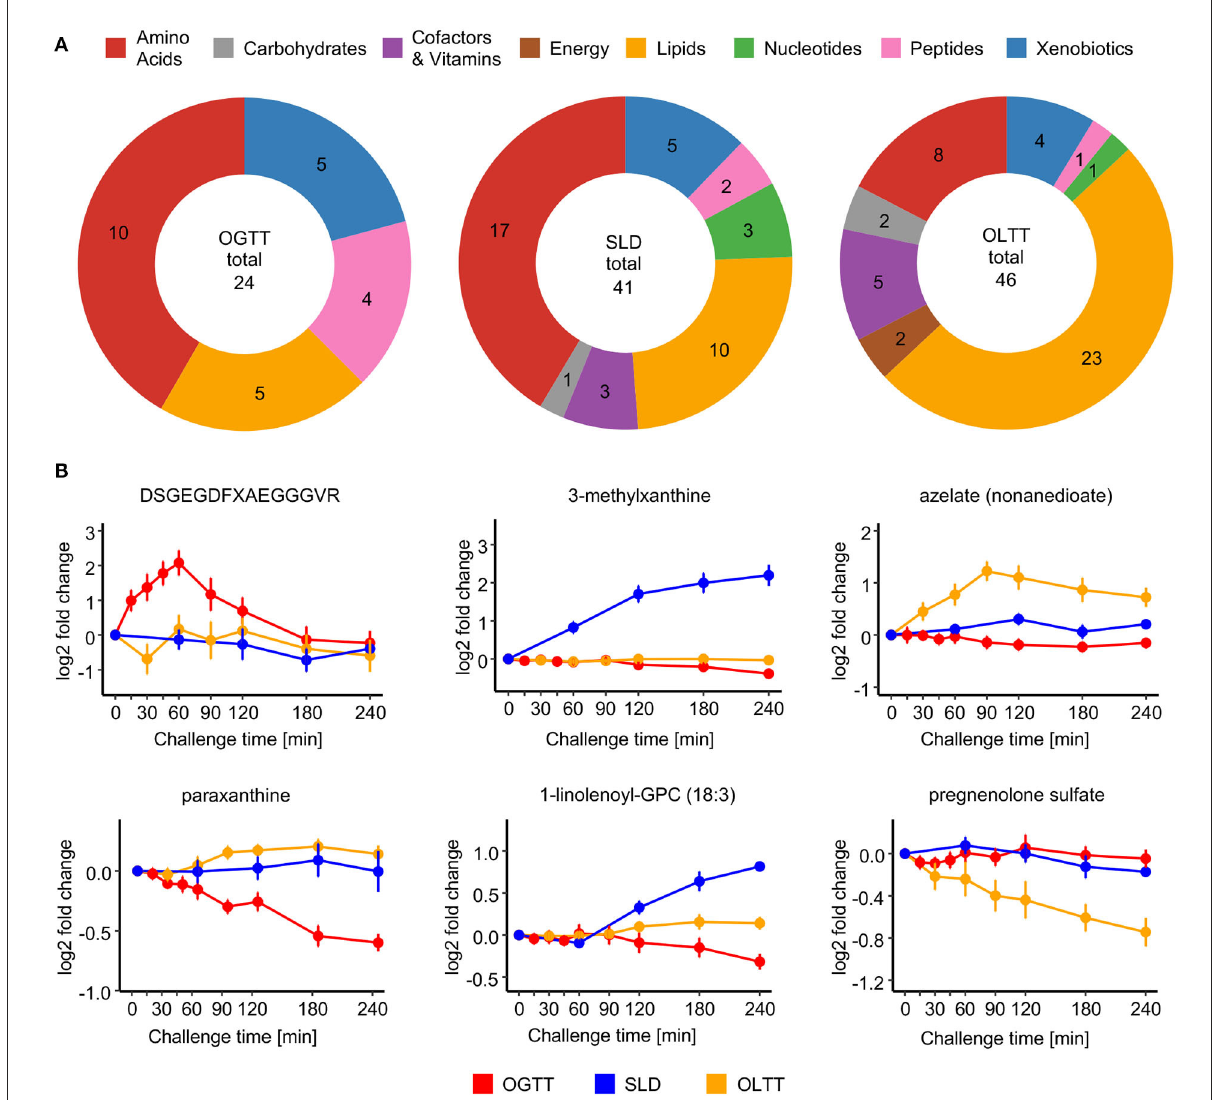
FIGURE6 Challenge-specific postprandial responses. (A) Distribution of metabolites with significant challenge-specific postprandial responses (Bonferroni adjusted p < 0.05) over metabolite classes. (B) Temporal profiles for selected examples of metabolites showing challenge-specific postprandial responses. Data are represented as mean across all 15 participants ±